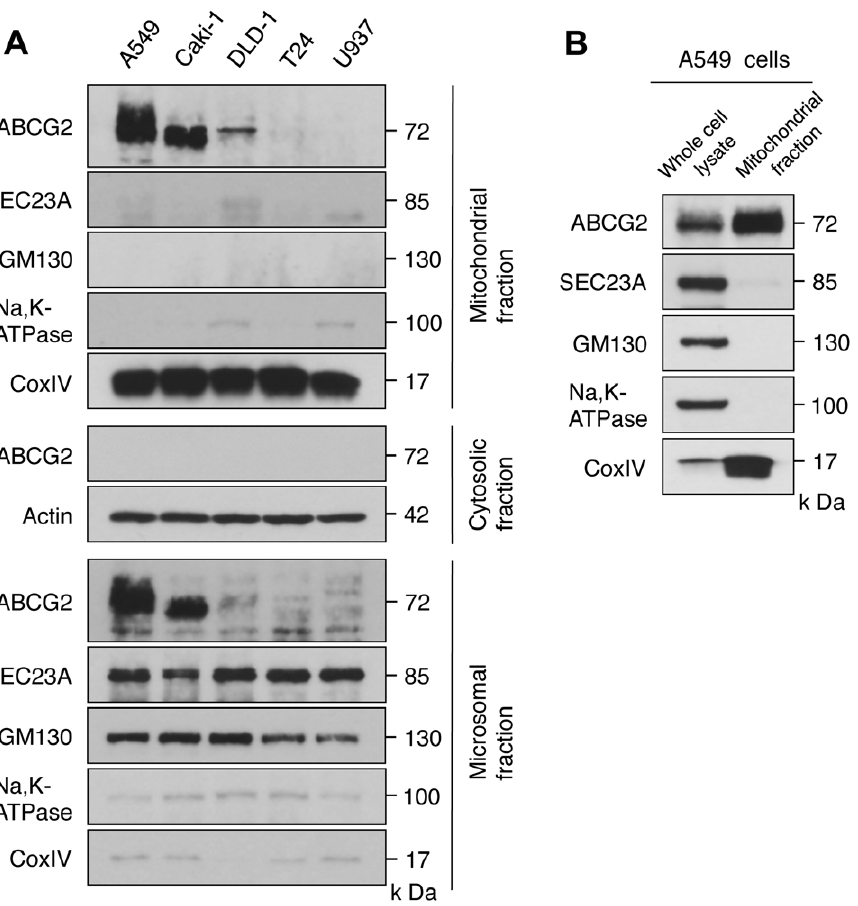
Figure 3. Distribution of ABCG2 in the mitochondrial fraction. A , Subcellular fractions were isolated by a centrifugation method as described in Materials and Methods. ABCG2 was detected by western blotting analysis using polyclonal anti-ABCG2 (Cat. # 4477; Cell Signaling Technology). CoxIV, Actin, SEC23A, GM130, and Na, K-ATPase were used as organelle-specific markers of mitochondria, cytosol, endoplasmic reticulum, Golgi apparatus, and plasma membrane, respectively. A representative blot of multiple experiments is shown. B , Highly purified mitochondria were isolated by OptiPrep density gradient centrifugation as described in Materials and Methods and the western blotting analysis was performed using antibodies as described in A. Equal volume of samples from both whole cell lysate and mitochondrial fraction of A549 cells were subjected to SDS-PAGE. A representative blot of multiple experiments is shown.